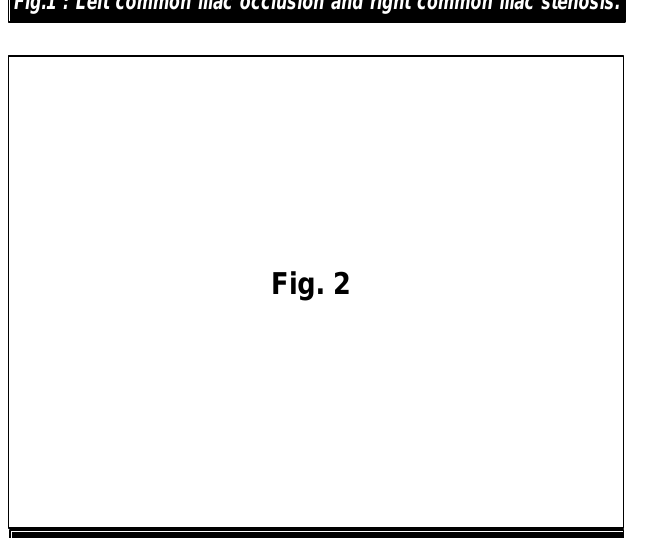
Fig.2 : Femoro popliteal bypass.